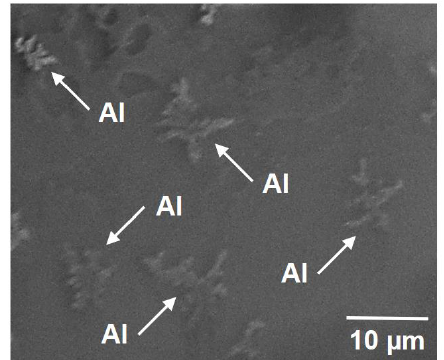
Fig. 3. Scanning-electron microscopy image of a classically- manufactured fused silica surface, taken at the edge of the component. The whitish flakes are aluminium-containing compounds as verified by energy-dispersive X-ray